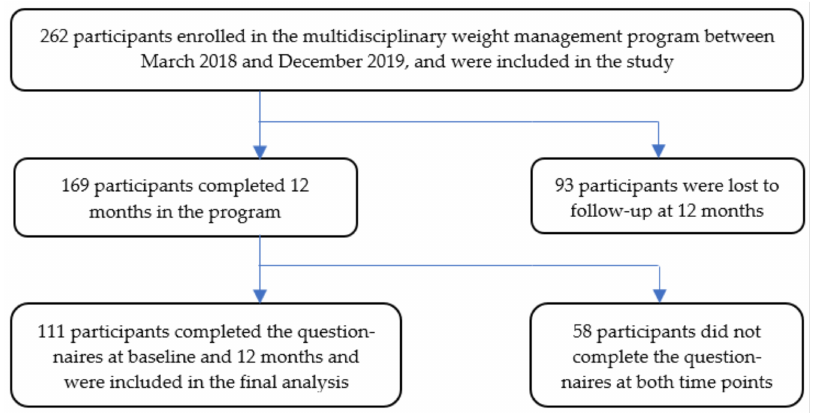
Figure 1. Entry of patients at baseline and loss to follow-up at 12